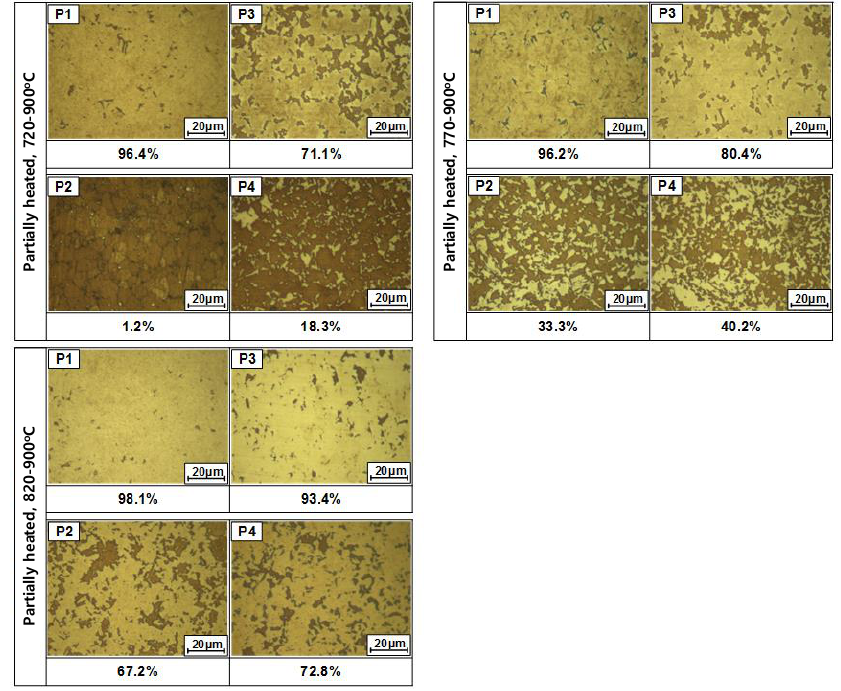
Figure 13. Measurement results for the volume fraction.